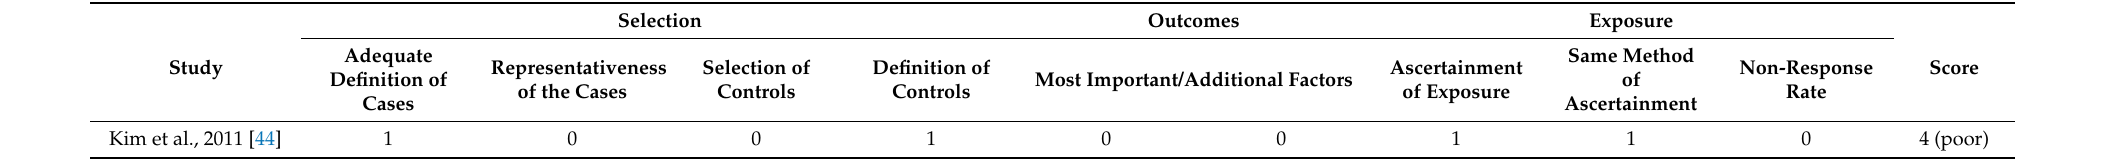
Table A4. Risk of bias assessment according to Newcastle–Ottawa scale for case–control